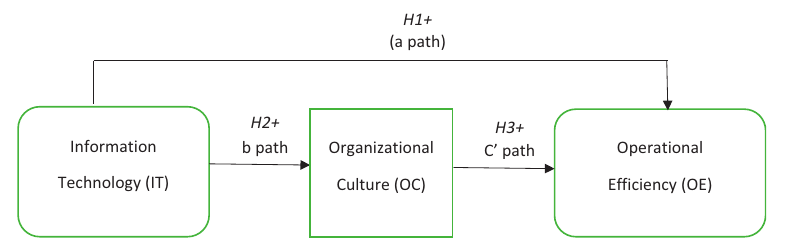
Figure 1. Conceptual